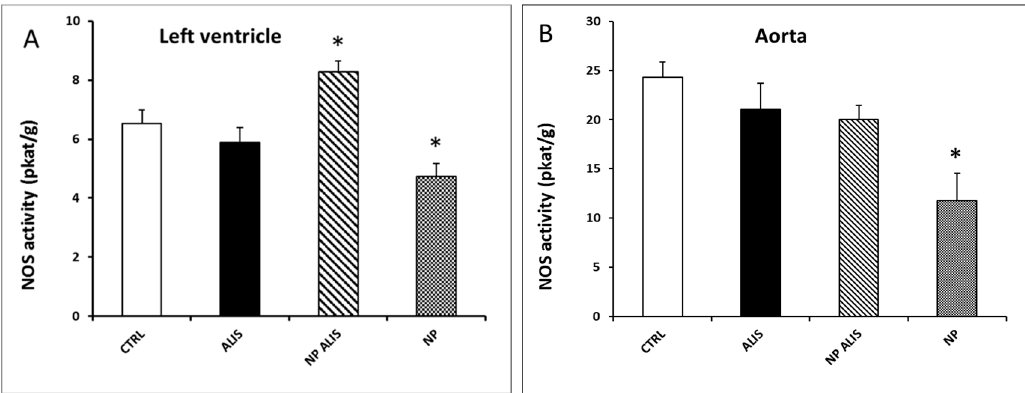
Figure 6. Effect of powdered aliskiren (ALIS), nanoparticle-loaded aliskiren (NP ALIS), and nanoparticles only (NP) on total nitric oxide synthase (NOS) activity in the left ventricle ( a ) and aorta ( b ). * p < 0.01 vs. CTRL; Values represent mean ± SEM of 6 animals.